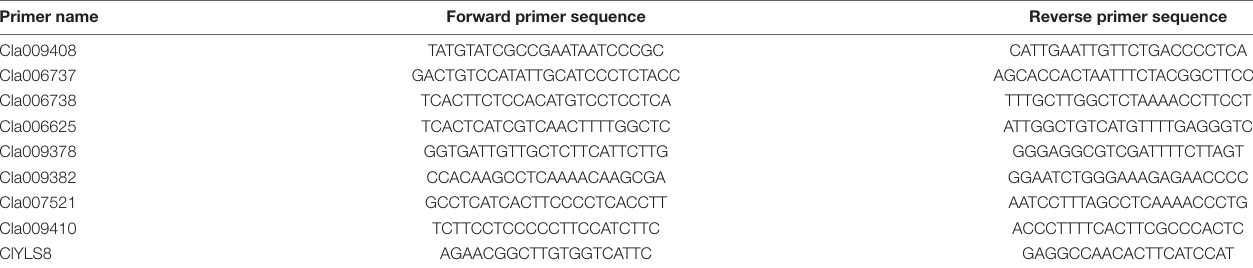
TABLE 1 | Sequence details for the qRT-PCR primers used to analyze watermelon candidate gene expression. Primer